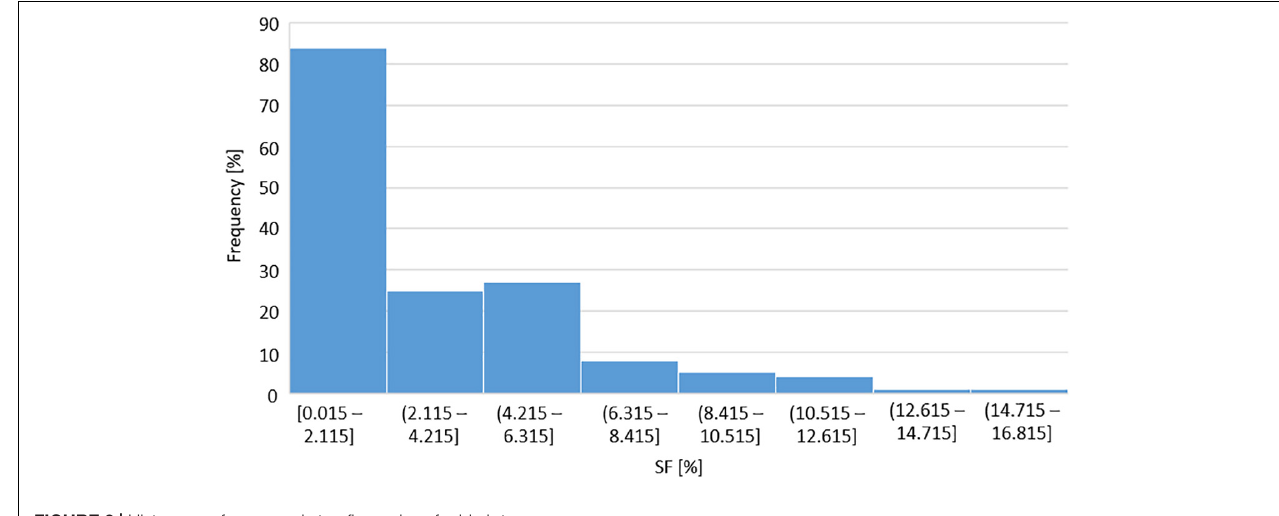
FIGURE 3 | Histogram of measured stemflow values for birch